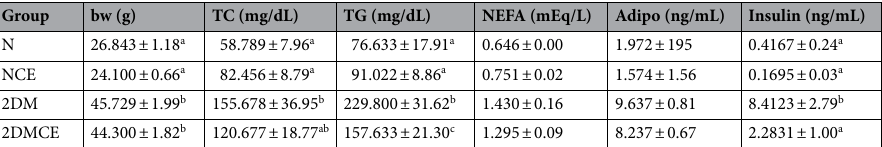
nonesterified fatty acid content, Adipo plasma adiponectin content, Insulin plasma insulin